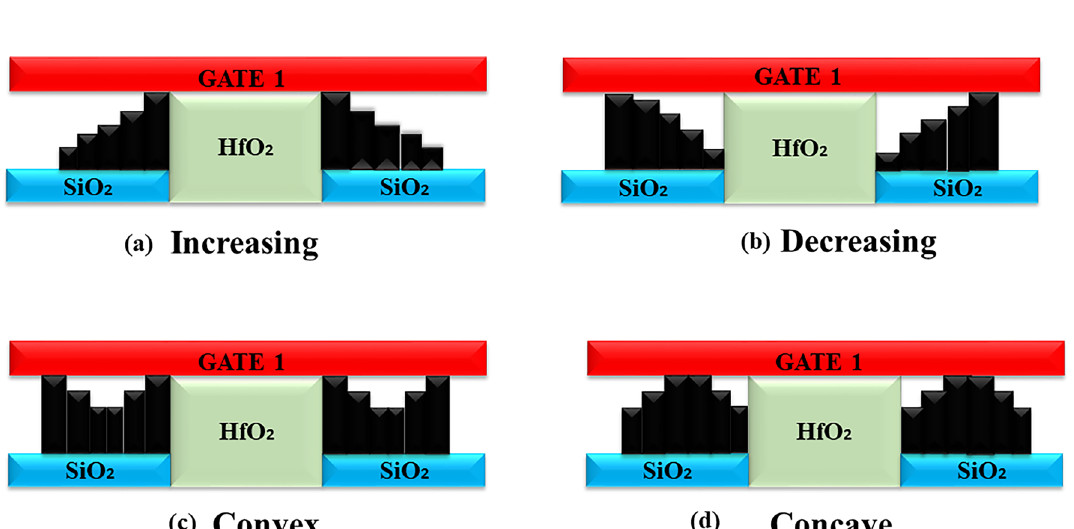
Figure 15. Partially filled cavity profiles ( a ) Decreasing, ( b ) Increasing, ( c ) Convex, and ( d )